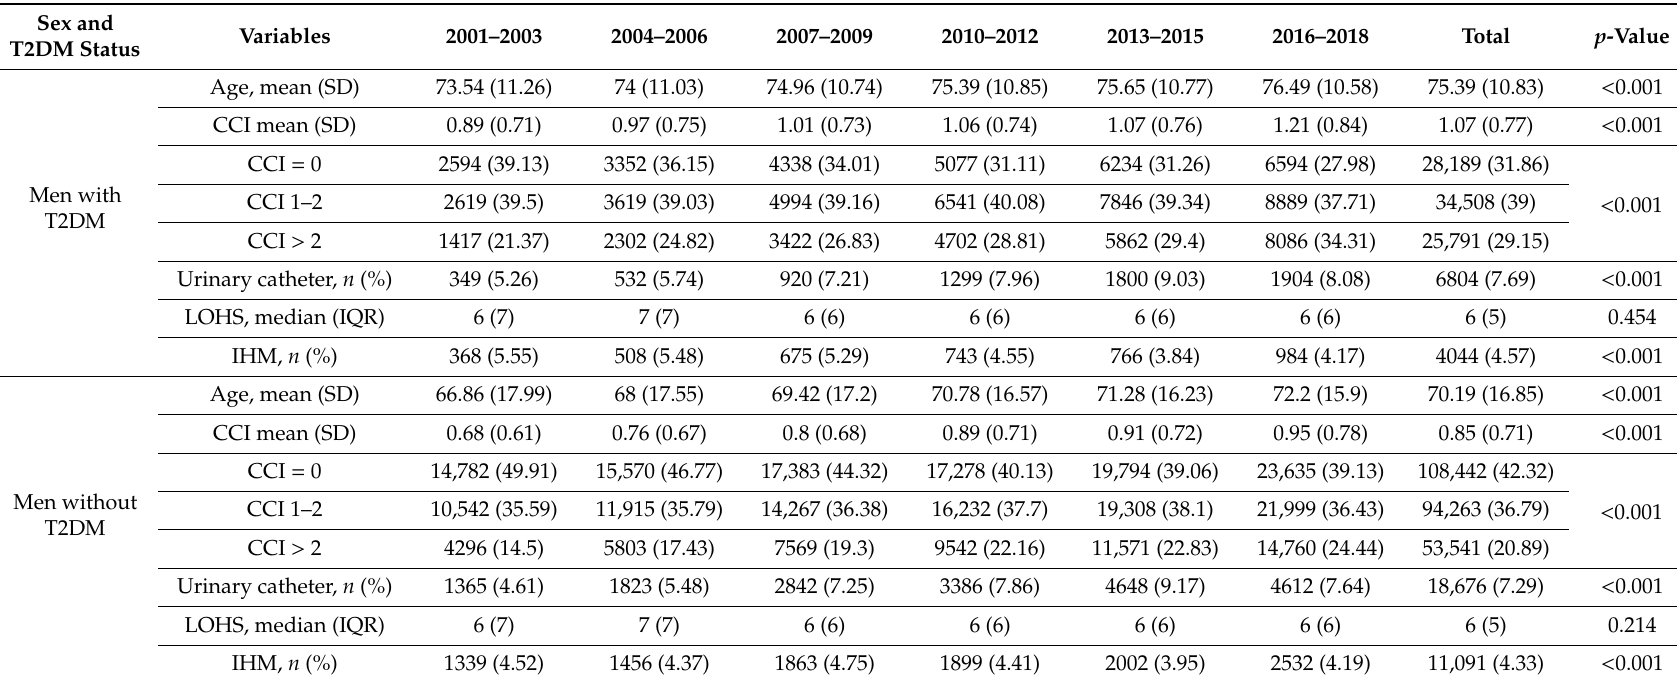
Table 2. Comorbidities, procedures, and in-hospital outcomes among patients with a principal diagnosis of urinary tract infections in Spain, 2001–2018, according to diabetes status and